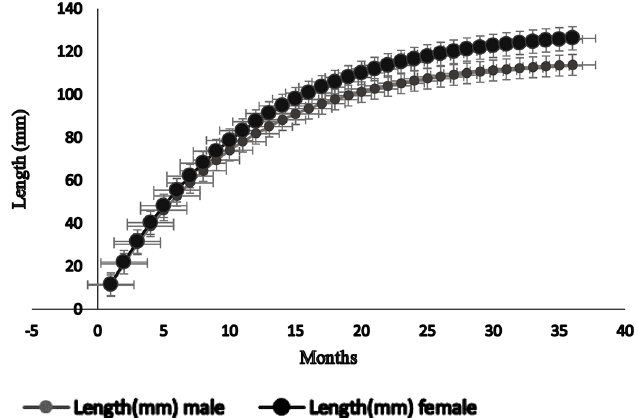
Fig. 3. Length at age for females and males of P. stylifera